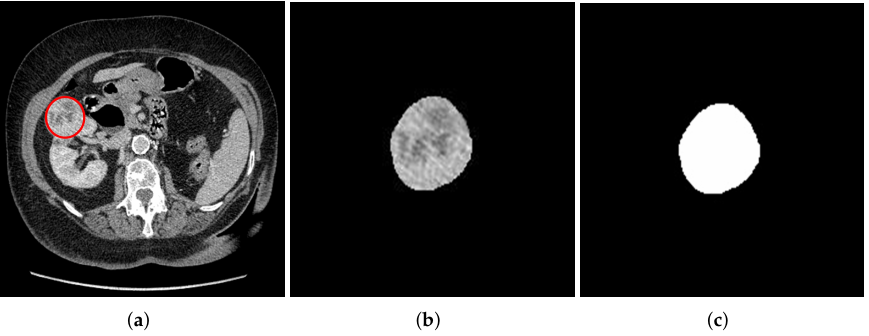
Figure 1. Manual 2D slice image segmentation using image segmentation toolbox in Matlab. ( a ) Orig- inal image with ROI. ( b ) Segmented tumor from the kidney. ( c ) Resulting mask from the 2D